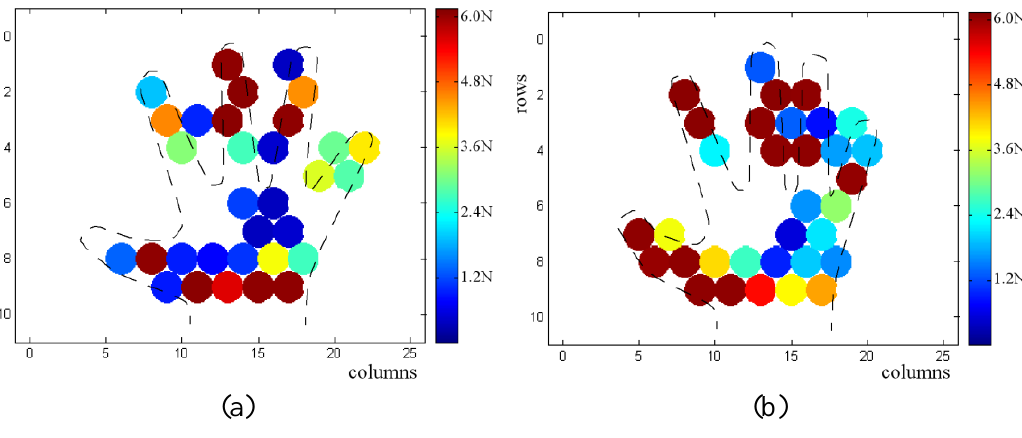
Figure 11. ( a ) and ( b ) two tactile images of a hand as registered by the tactile